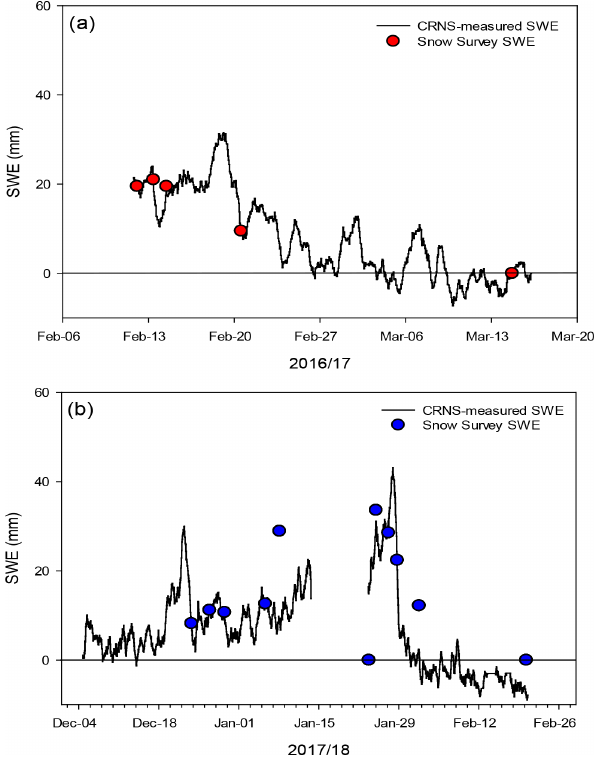
Figure 6. Continuous measurement of SWE at the low-SWE Elora site during the (a) 2016/2017 and (b) 2017/2018 winter seasons. When SWE values are negative, the CRNS is recording a lower near-surface water content than its baseline. CRNS SWE values were calculated using Eq.